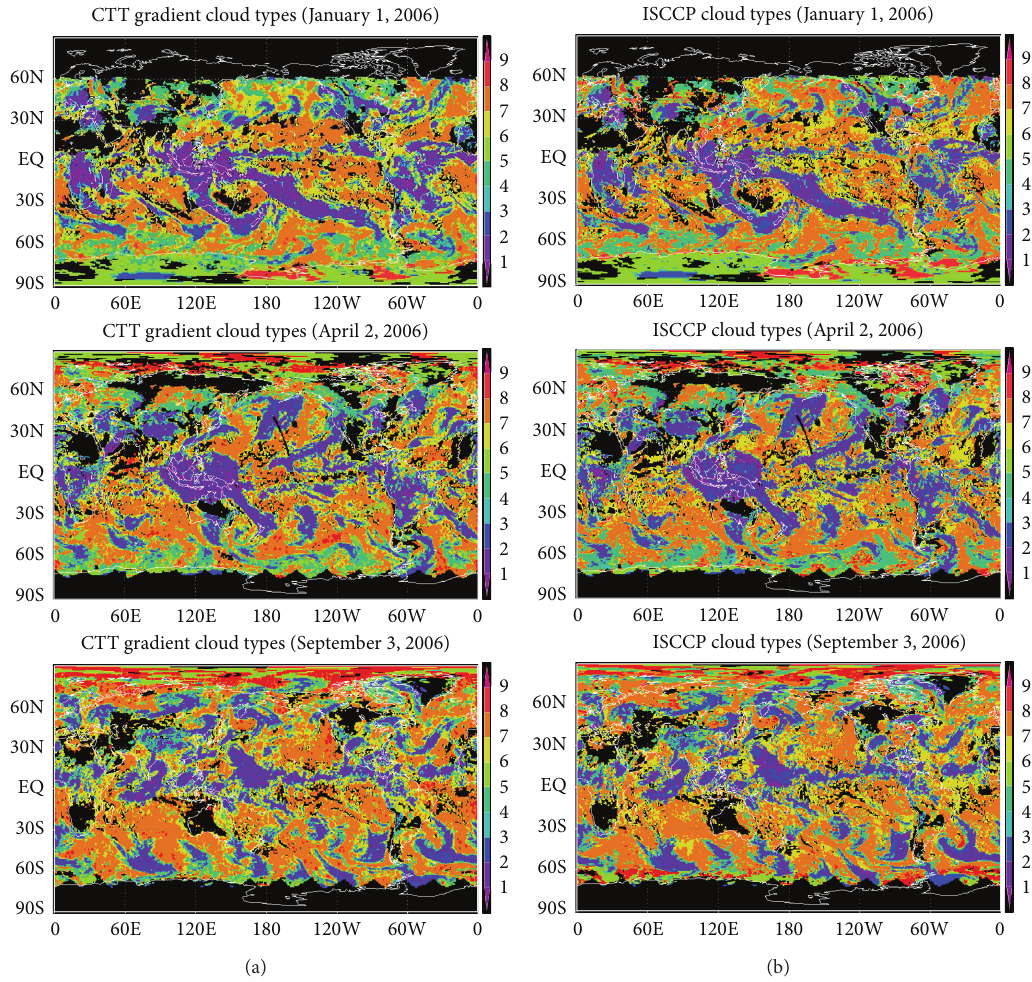
Figure 5: Cloud type classification using the thermal image segmentation method based on cloud top temperature (CTT) gradient classification (a) compared to the cloud type classification using the ISCCP classification method (b) for spring and end of summer (April 2 and September 3, 2006, resp.). 1: cirrus, 2: cirrostratus, 3: deep convection, 4: altocumulus, 5: altostratus, 6: nimbostratus, 7: cumulus, 8: strato-cumulus, and 9: